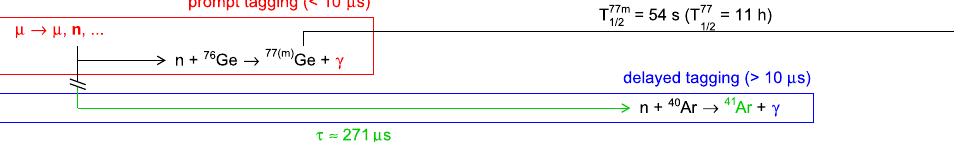
Fig. 6 Sequence of the delayed coincidence cut based on tagging by prompt and delayed coincidences between muon veto and germanium detector signals. The delayed signals are mainly provided by capture of thermalized neutrons in the surrounding LAr. The comparably short half-life of 77 m Ge allows for suppression by a delayed coincidence cut